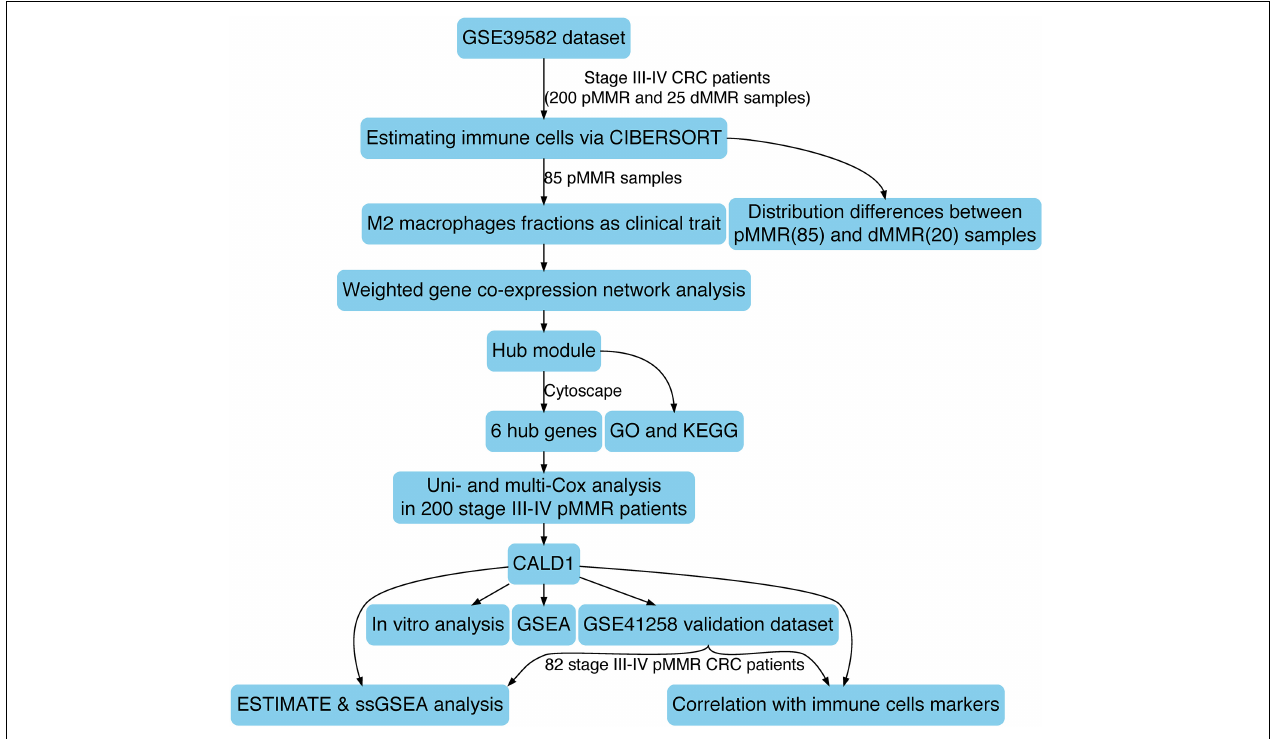
FIGURE 1 | The schematic diagram of this